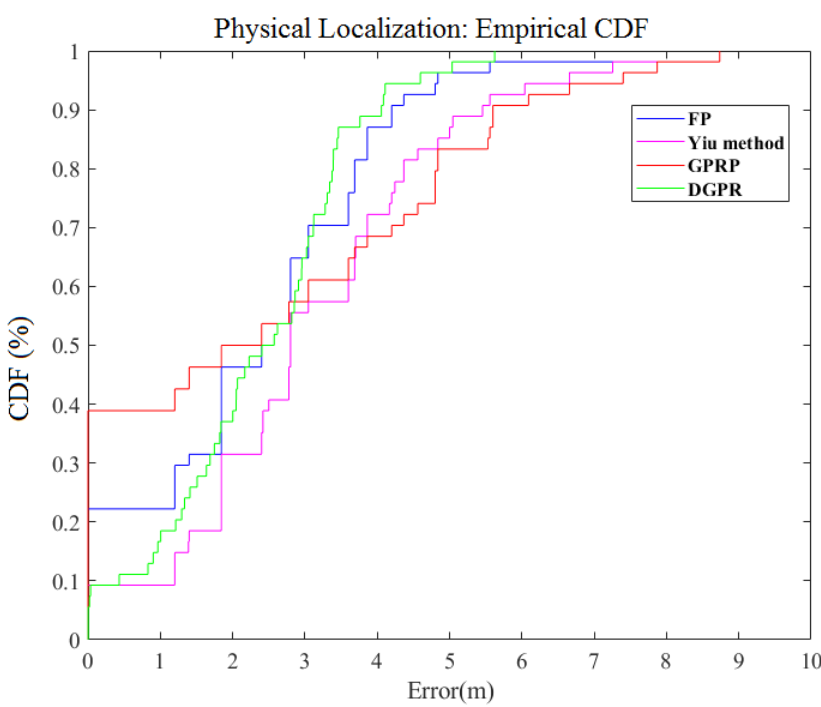
Figure 7. Comparison of CDF for physical localization error of different algorithms.